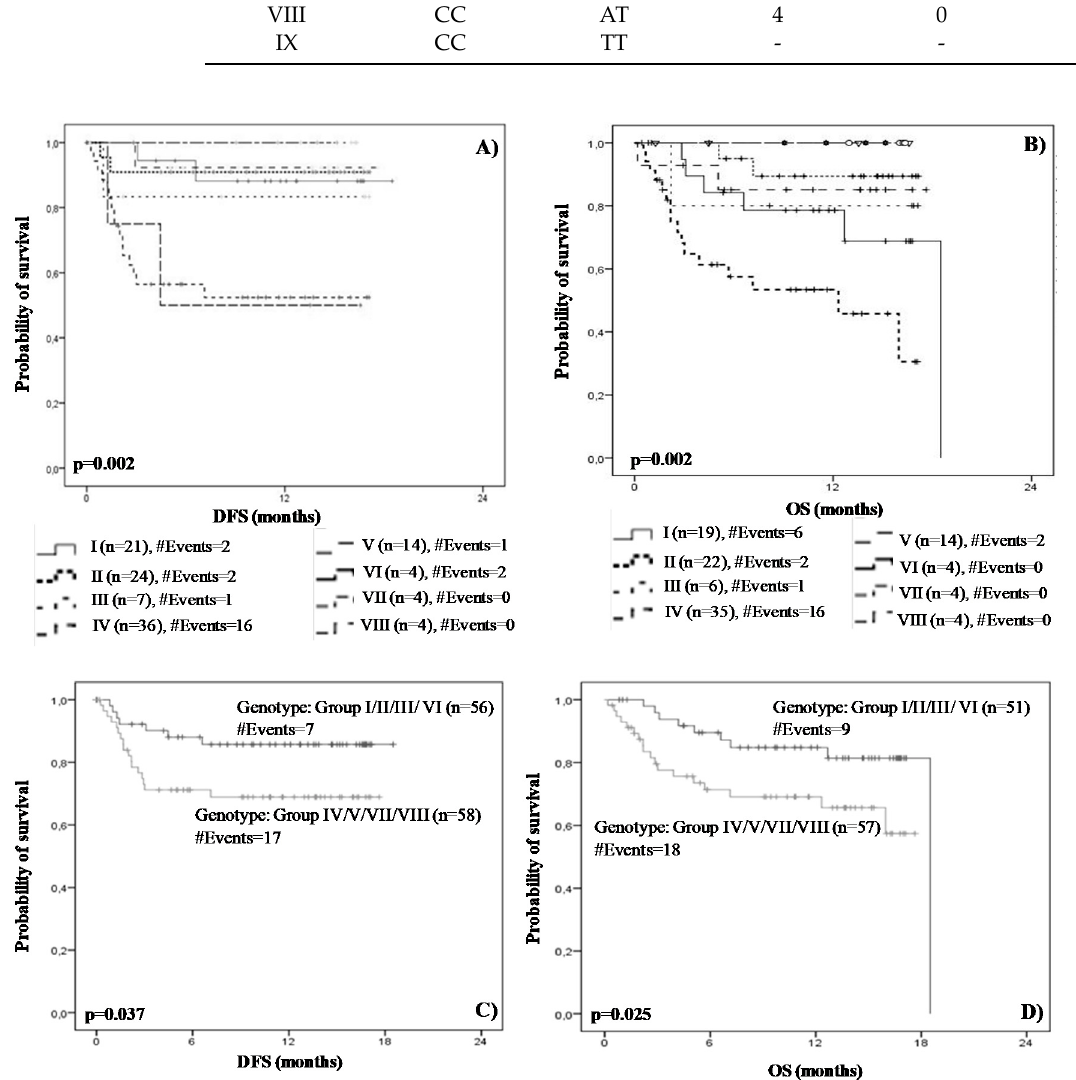
Figure 6. Kaplan–Meier disease-free ( A , C ) and overall ( B , D ) survival curves, after patients’ stratification. p values were calculated by log-rank test.